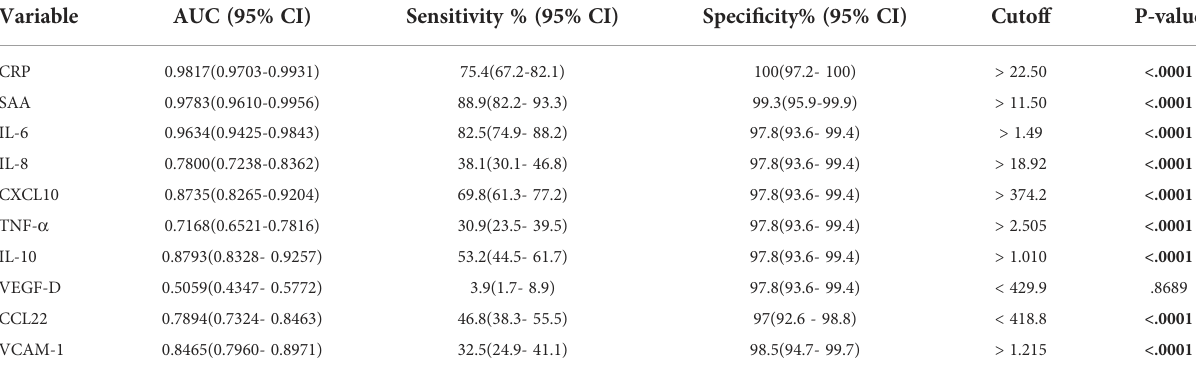
TABLE 7 Area under the receiver operating characteristic curve, sensitivity, speci fi city & cutoff values of speci fi c in fl ammatory markers of distinguishing healthy controls and cases.